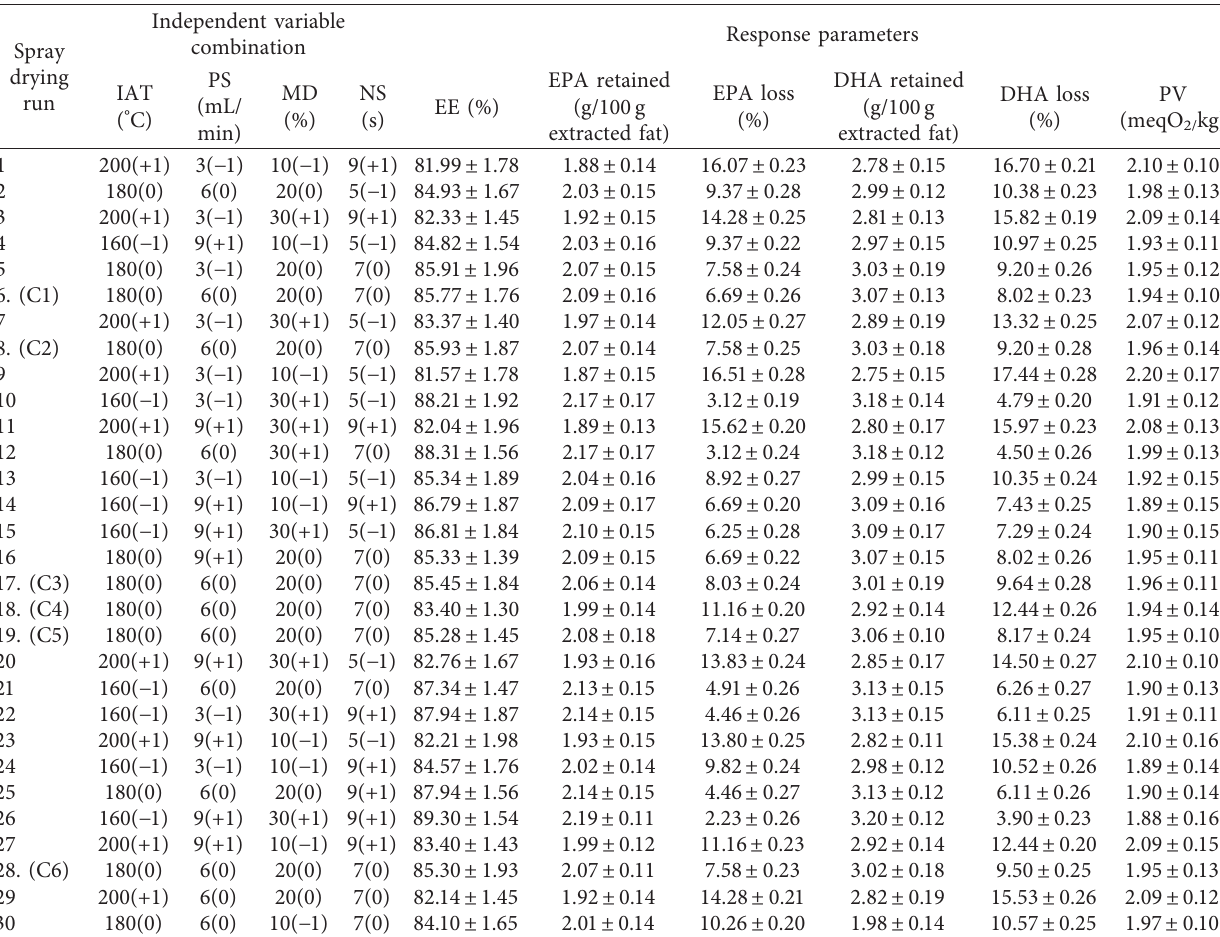
Table 3: Effect of spray drying conditions on the response